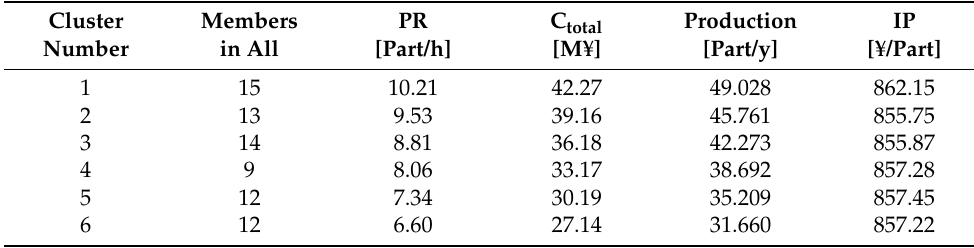
Table A8. Cluster analysis of the new approach (Case C).